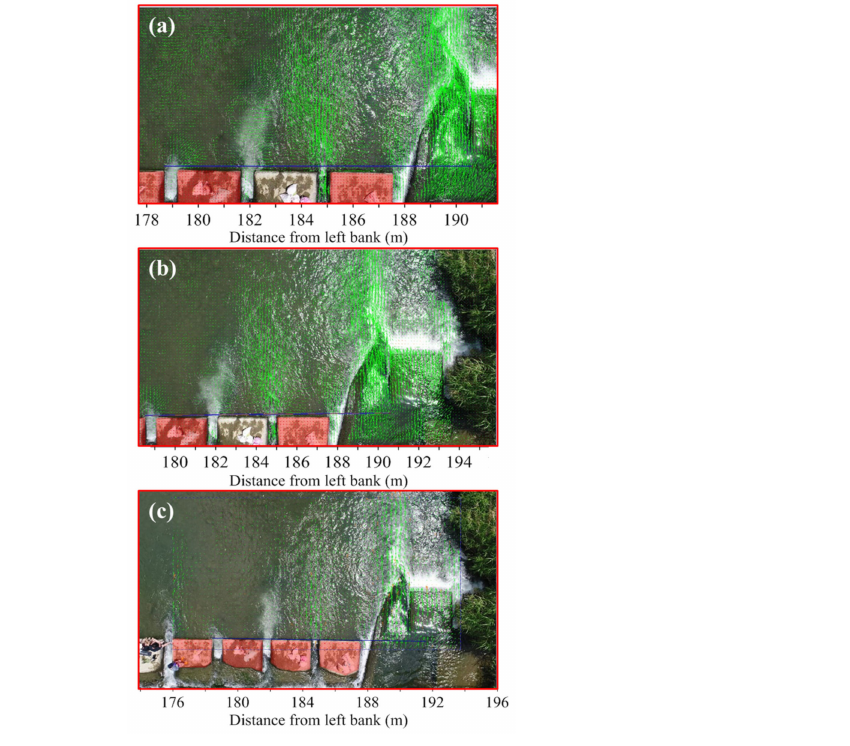
Figure 5. Flow field measurements obtained using LSPIV derived from UAVs with different flight heights: ( a ) 9 m, ( b ) 12 m, and ( c ) 15 m. The blue line in figure ( a ) represents the x -axis